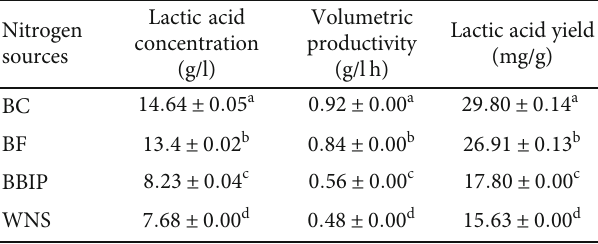
a,b,c,d Values with di ff erent letters on the same column di ff er signi fi cantly each other ( p < 0 : 05 ). Table 5: Proximate composition of BC and